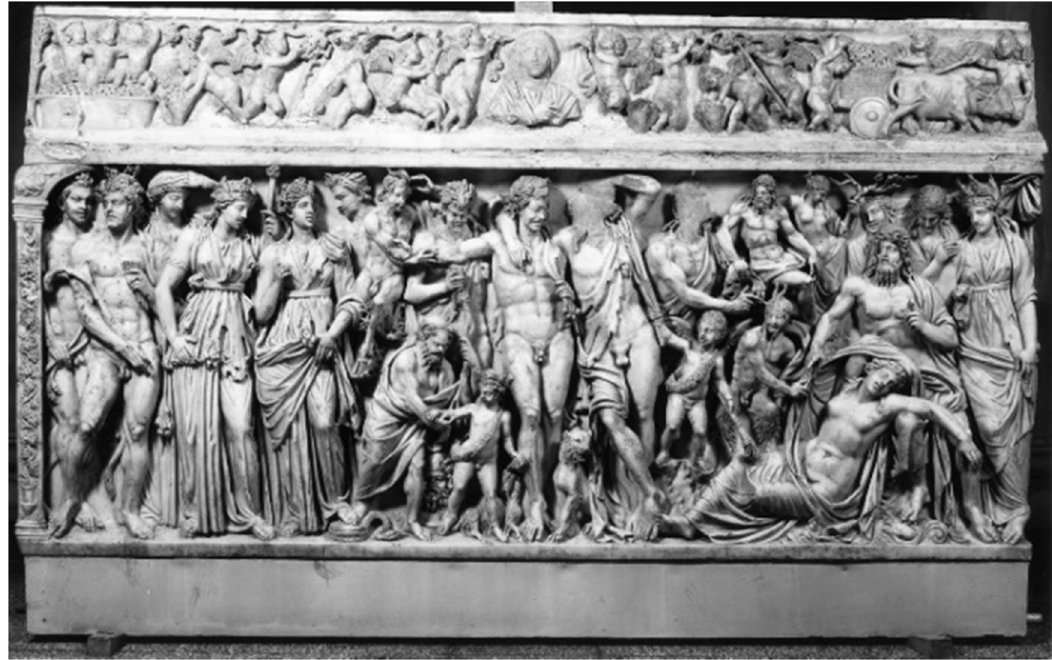
Figure 30: Sarcophagus. Weddings of Dionysus and Ariadne , 190 – 200 CE. Walters Art Museum, Baltimore, Maryland. Public